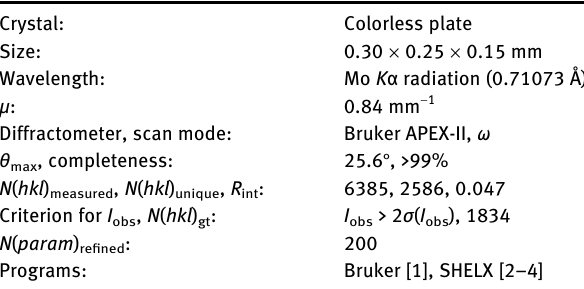
Table  : Data collection and